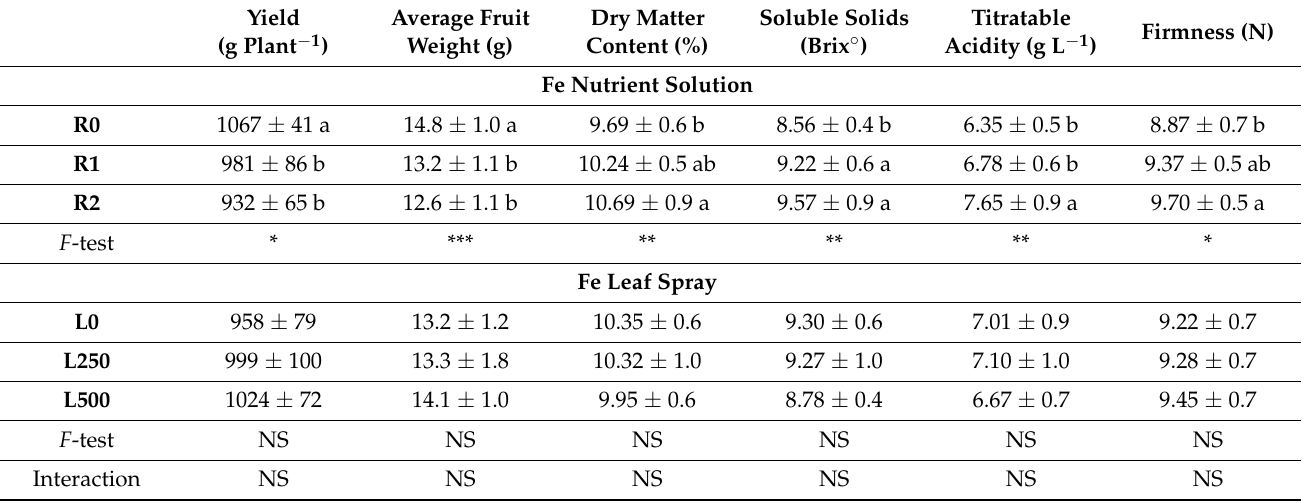
Table 1. Effects of Fe application on the yield and carpometric parameters of cherry tomato fruits.